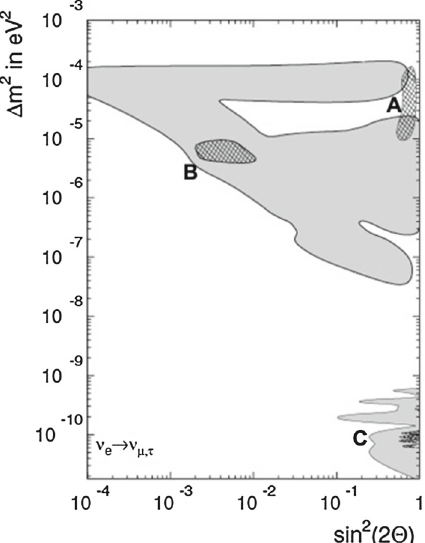
Fig. 10 Excluded region only by the Super-K energy spectrum and time variation measurement without the flux normalization are shown by the gray region [59]. The allowed parameter regions by all the solar neutrino experiments including the flux normalization are shown by the hatched regions: a the large mixing angle solutions (LMA); b the small mixing angle solutions (SMA); and c the vacuum oscillation solutions (VO). SMA and VO are excluded by Super-K. LMA remain as possible oscillation parameters